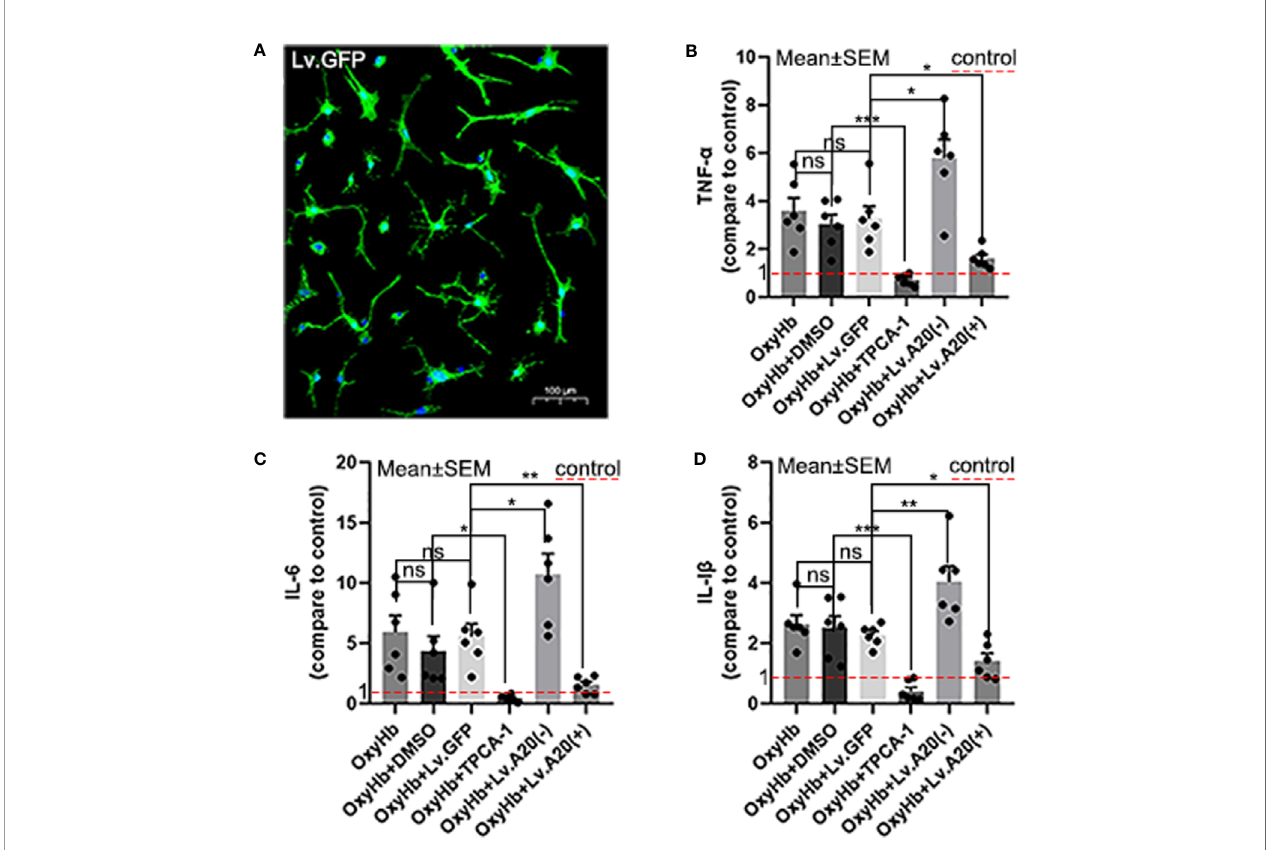
FIGURE 4 | A20 in fl uences in fl ammatory cytokine secretion by the microglia. (A) Image showing the transfection of Lv.GFP in microglia. (B-D) Microglia secreted in fl ammatory cytokines (IL-6, IL-1 b , and TNF- a ) after OxyHb stimulation. The red dotted line in the diagram indicated the levels of in fl ammatory factor secretion in the control group. Data are expressed as mean ± SEM, n = 6, * p < 0.05, ** p < 0.01, *** p < 0.005, ns versus OxyHb. ns, non-signi fi